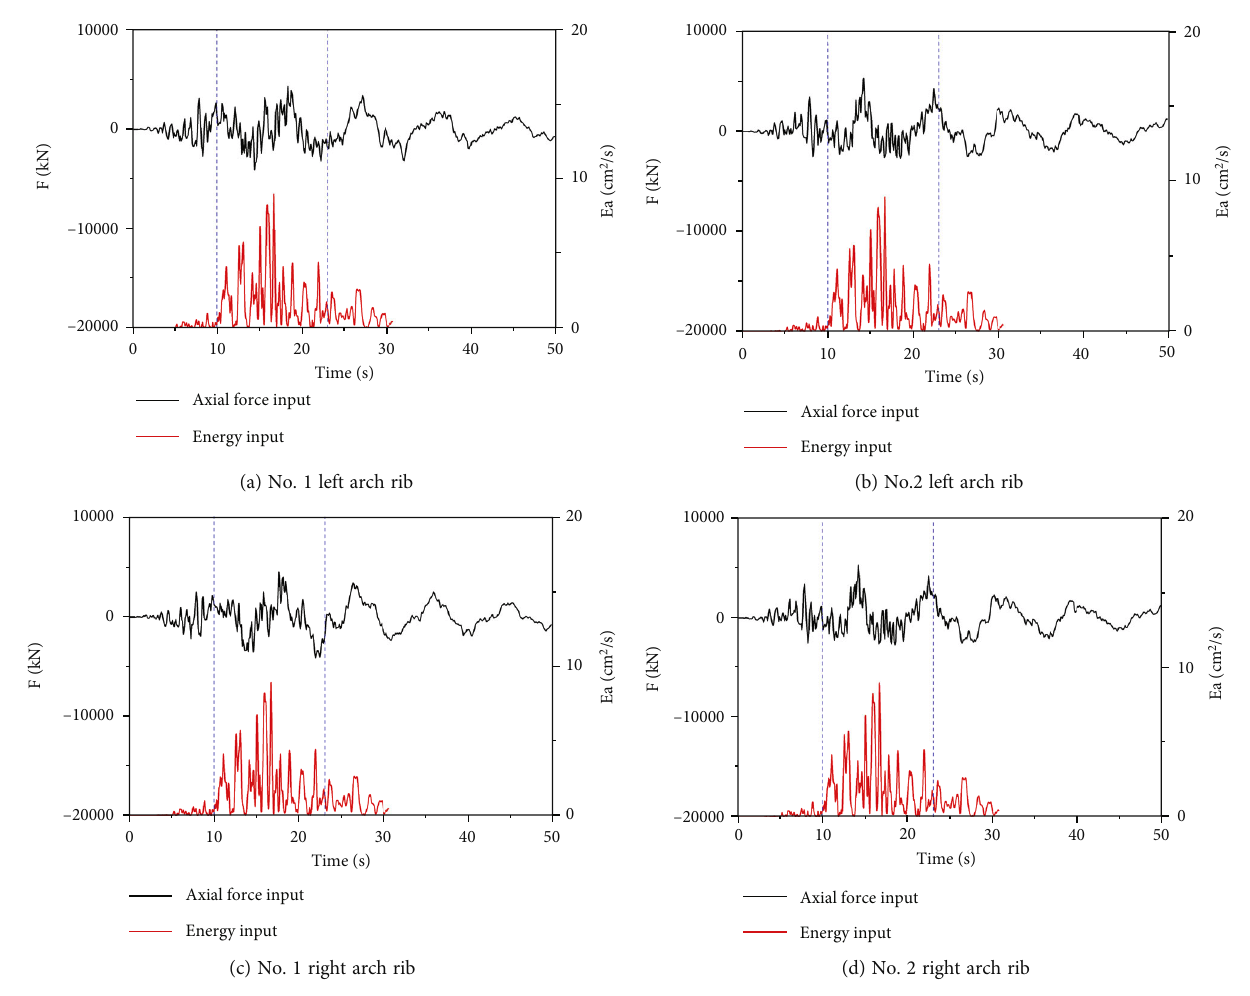
Figure 6: Axial force at the arch support during non-near-fault ground motion. Table 5: Damage index of bridge components under near-fault Table 4: Damage index range of bridge structure under di ff erent ground damage degrees.